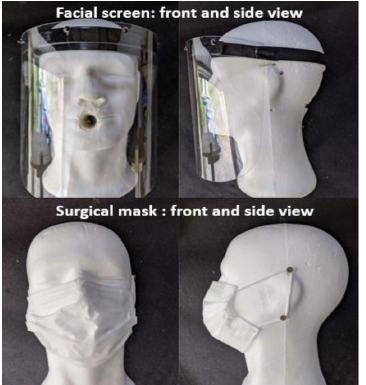
Figure 2. Surgical mask type I and face shield (front and profile